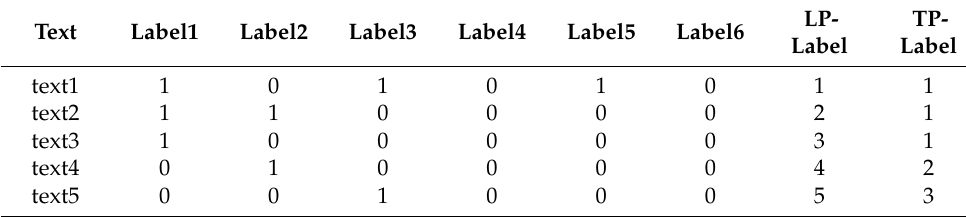
Table 5. The data format after transformation by LP/TP